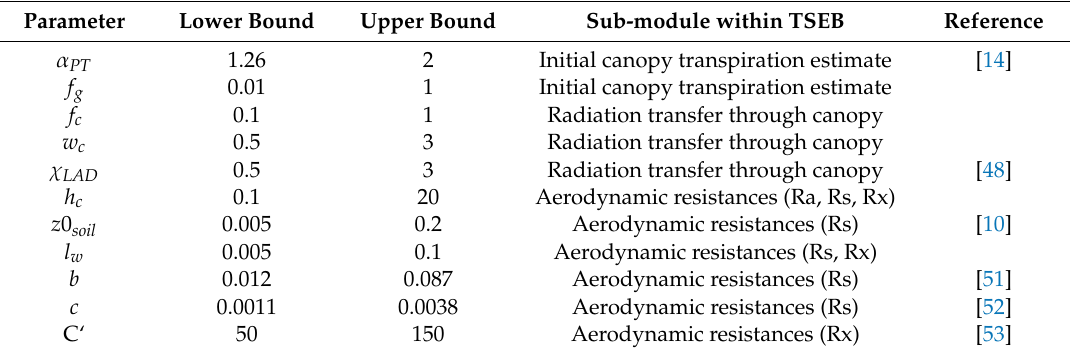
Table 3. Parameters bounds for the Sobol’ global